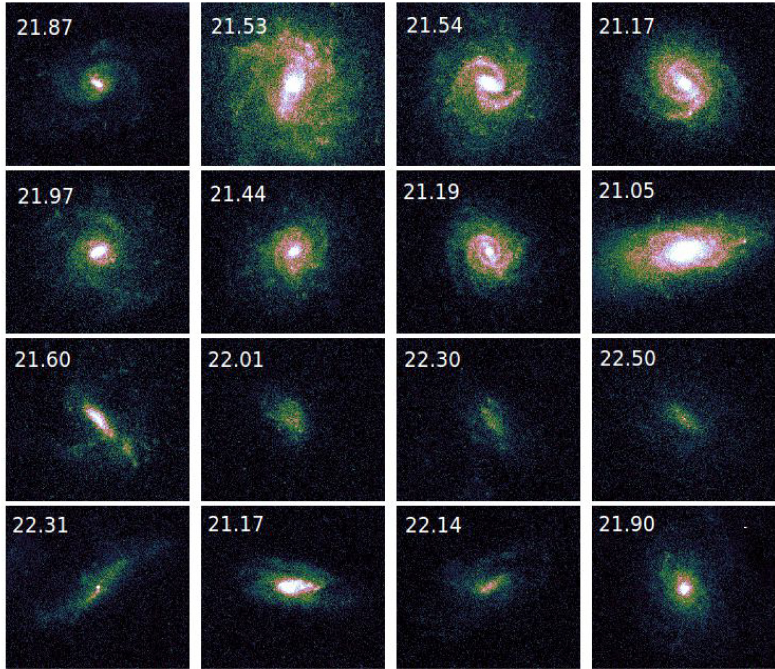
Figure 9. R-band images of representative LSBs. The disc central surface brightness (in units of Figure 1. A few representative galaxies of different morphologies in our sample in r -band. The disc central surface brightness (in units of mag arcsec -2 ) is indicated on the top of each galaxy. The colour scale is same for all images. magarcsec − 2 ) is indicated. Image reproduced from (ii) The exponential profile for the disc is given by: